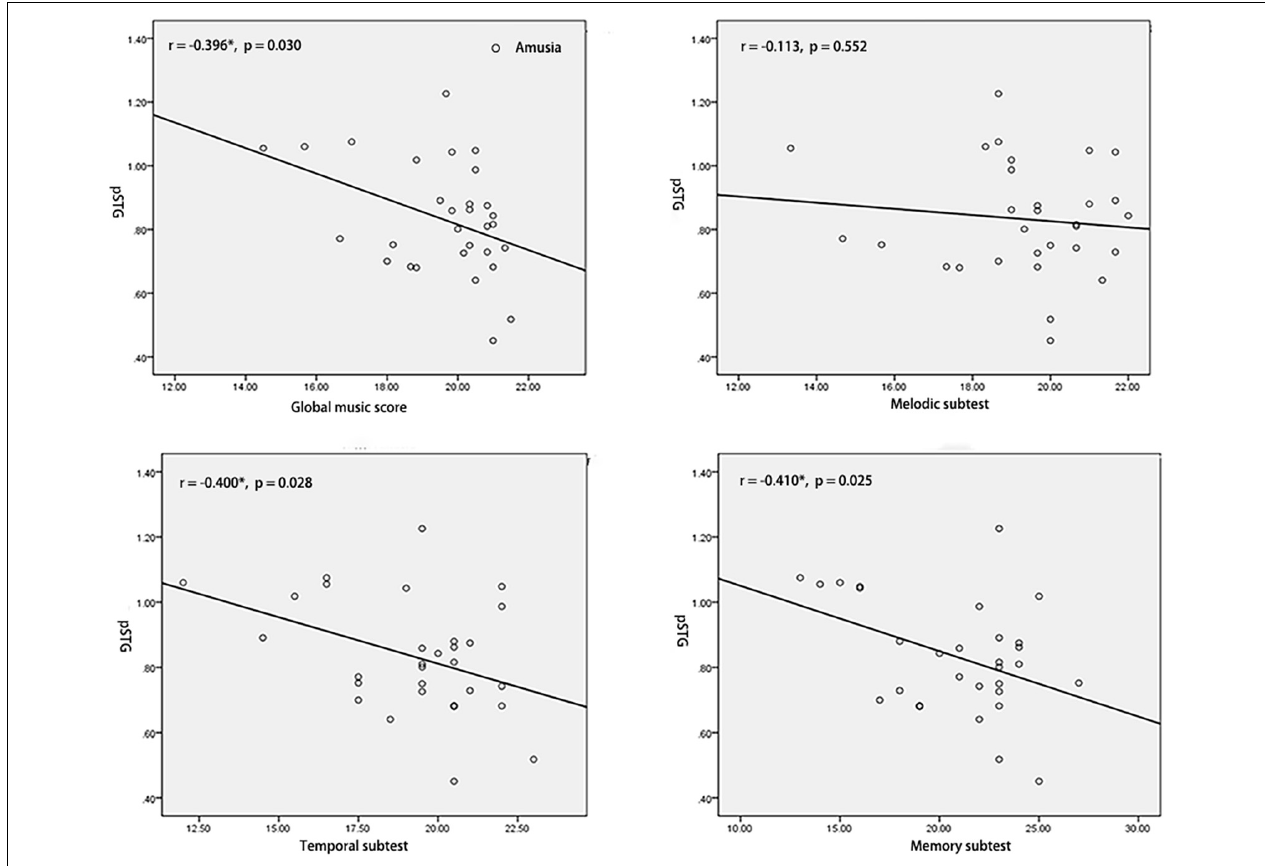
FIGURE 2 | Correlation analyses between the mean value of pSTG and MBEA scores in amusia group. * p <